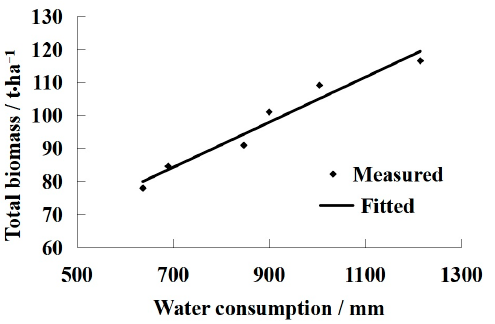
Figure 9. Relationship between total biomass (dry mass and yield) and water consumption.